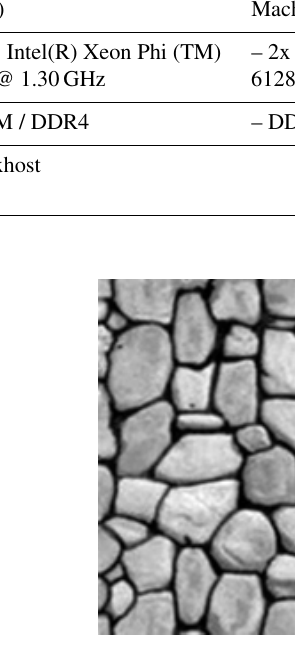
Figure 4. Training image that was used for benchmarking and sen- sitivity